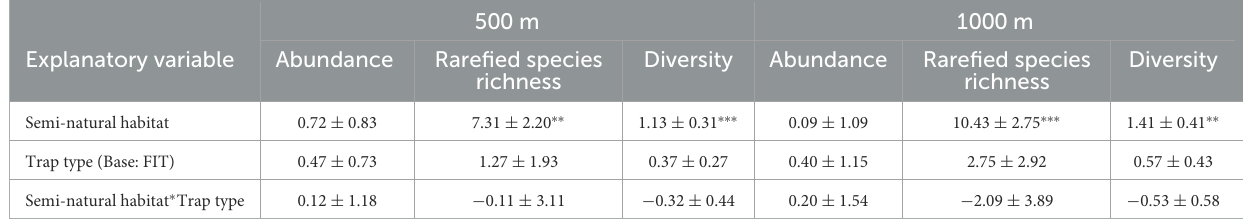
TABLE 1 The impact of sampling methods (FIT and PT; base: FIT), the proportion of semi-natural habitat and their interactions on wild pollinator abundance per sampling day, rarefied species richness and Shannon diversity in large scale (1000m radius) and small scale (500 m